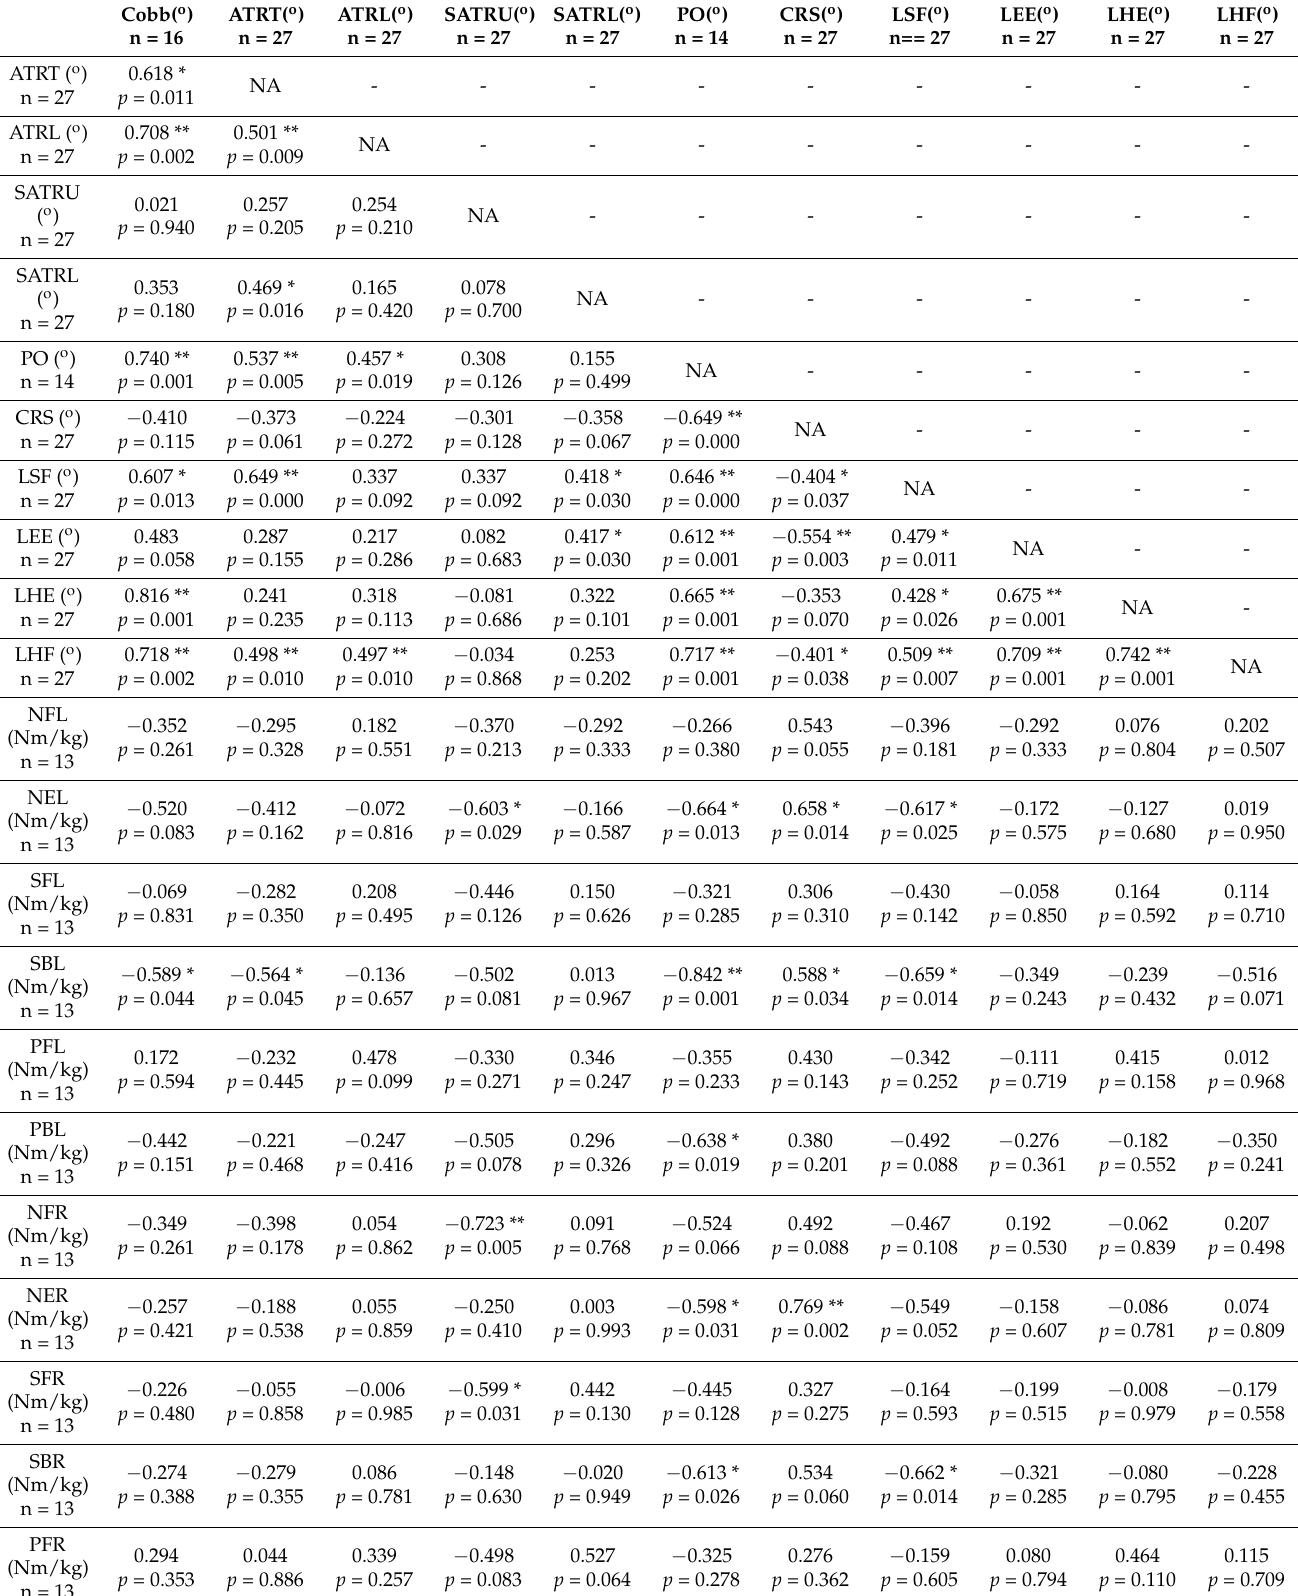
Table 4. Relationships between spinal deformity, ROM and muscle strength in all